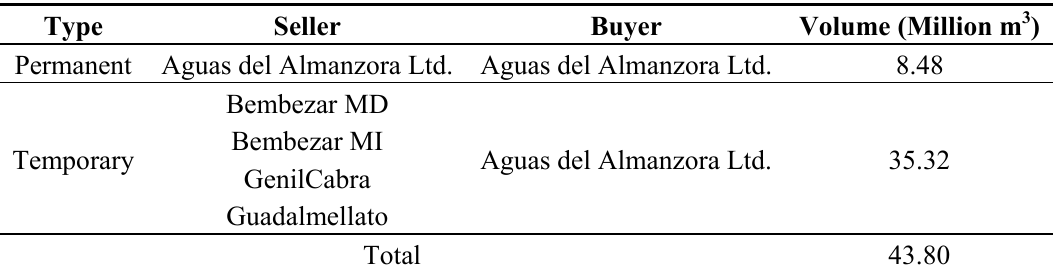
Table 1. Water market in southern Spain (2006–2007), source: Own